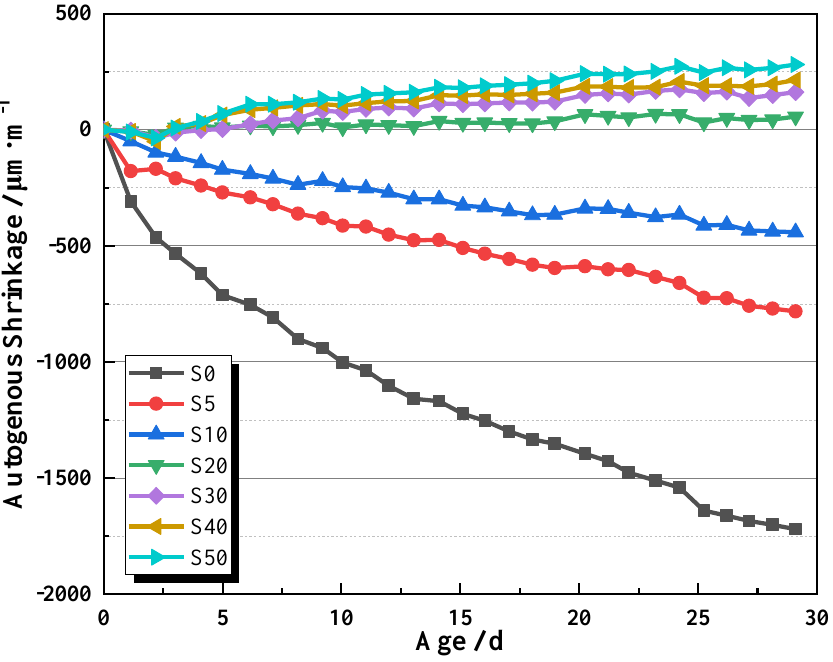
Figure 5. The autogenous shrinkage of AAS mortars as a function of curing time 3.3. Microstructure analysis.